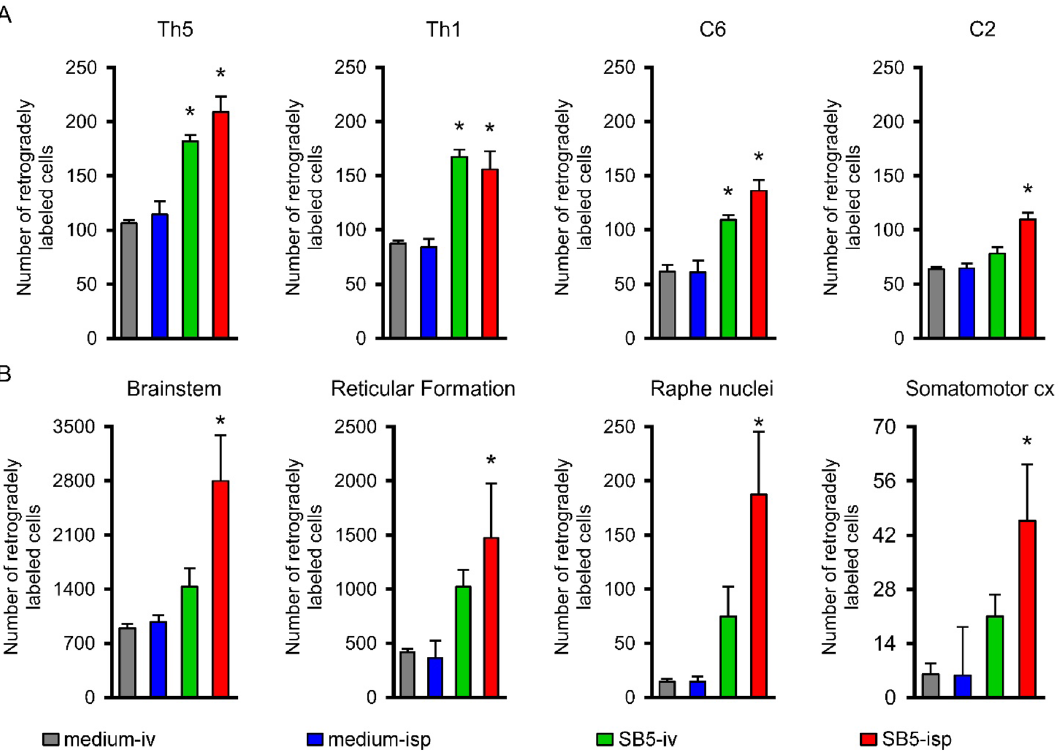
Figure 3. Morphometric analysis of the connections between the segments caudal to the lesion and various cranial parts of the CNS. ( A ) Numbers of neurons retrogradely labeled from the right L3 hemisegment are shown. Note the significantly higher numbers of labeled cells in the spinal cord of the hiPSC treated animals ( SB5-iv , SB5-isp ) compared with their controls ( medium-iv , medium-isp ). The greatest number of retrogradely labeled cells was always found in the intraspinally treated animals. ( B ) Significantly greater numbers of traced neurons are found in the brainstem, reticular formation, the raphe nuclei and the somatomotor cortex of intraspinally transplanted animals as compared with their controls. Note the limited regenerative capacity in the case of intravenous delivery of stem cells. Data are expressed as mean ± SEM. (n = 4 in each group) *significant difference between the intraspinally or intravenously grafted animals with the control ones in A. *significant difference between the intraspinally grafted animals and its control in